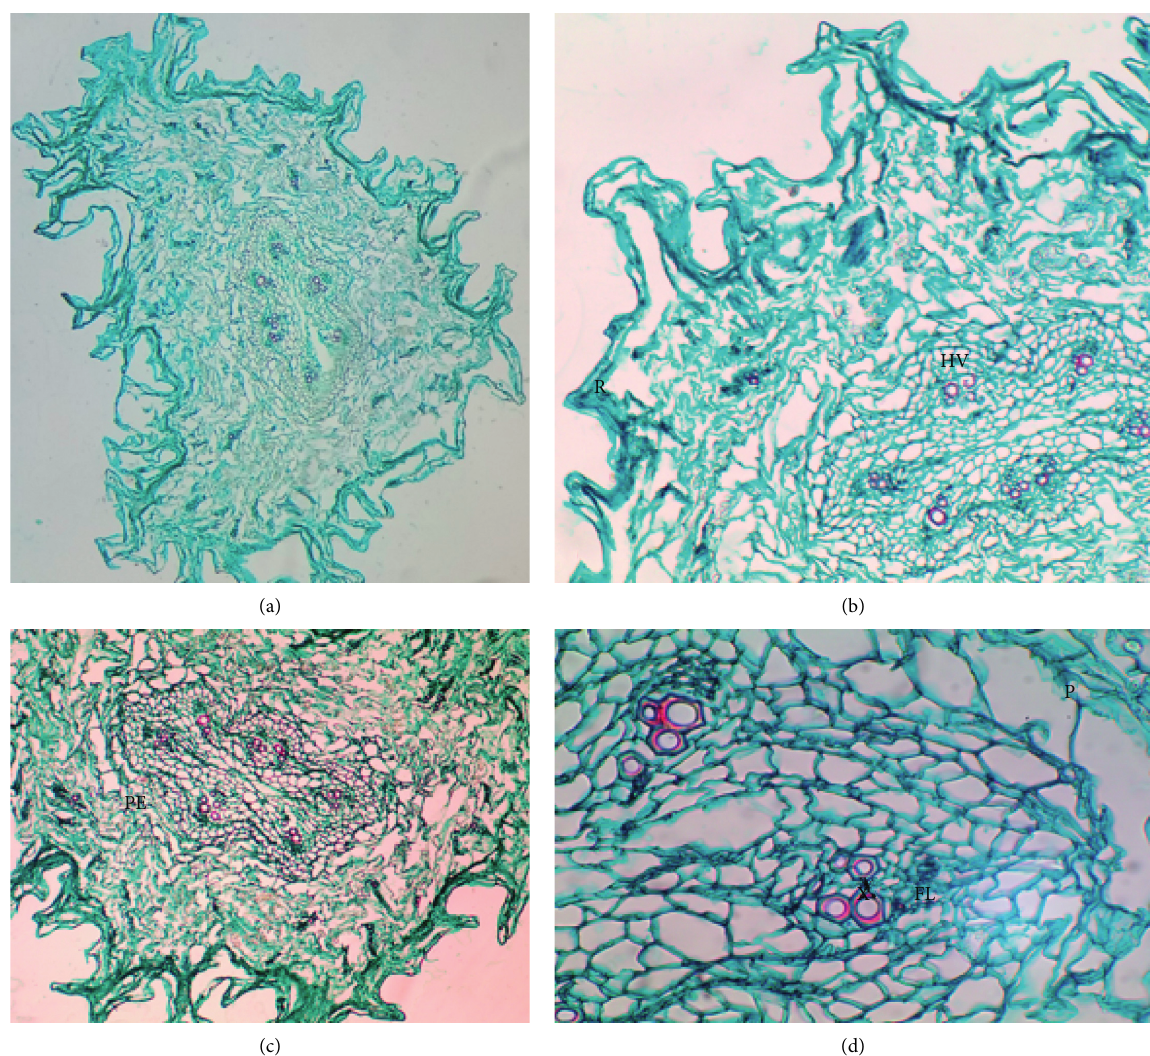
Figure 8: Image of root cross-section of the specimen from the Puchuncav´ı commune. Full root view, 4X magnification (a); rhizodermis (R) and vascular bundle (HV), 10X magnification (b); pericycle (P), 10X magnification (c); vascular bundle (phloem and xylem) in 40X magnification